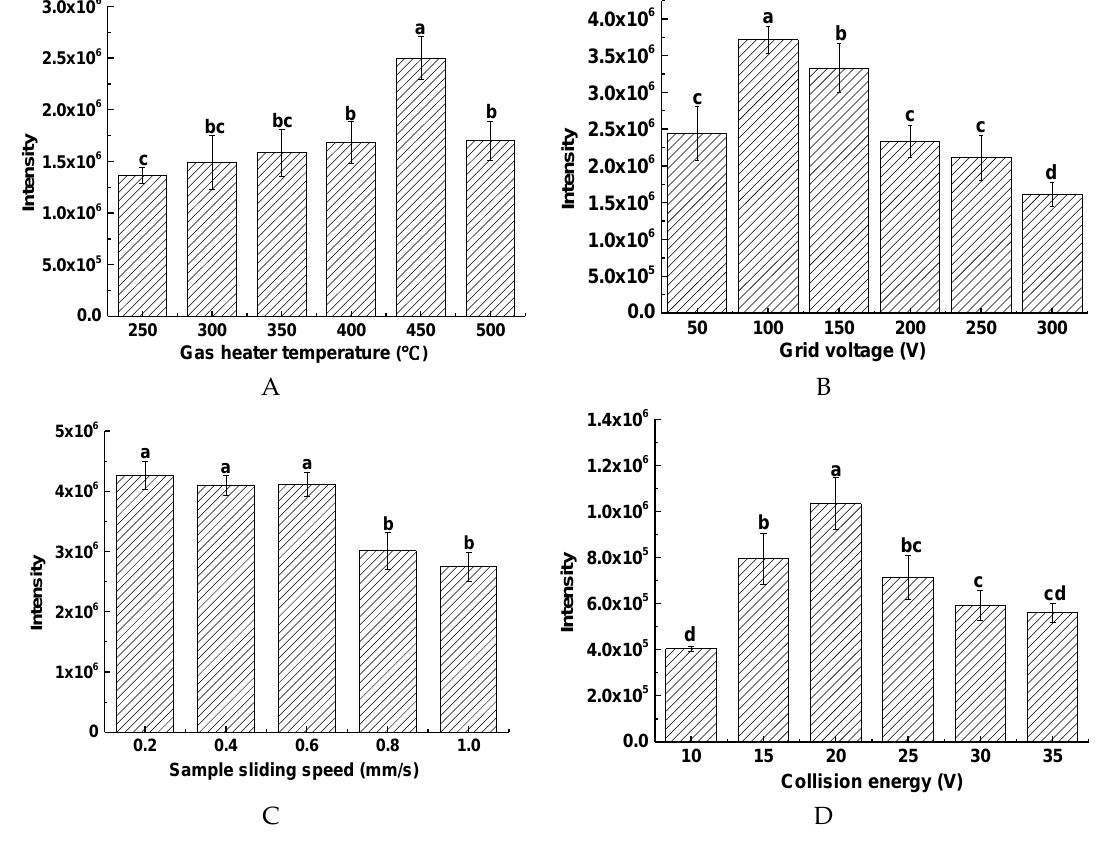
Figure 3. Optimization of determination conditions of SPD by DART-MS/MS: ( A ) gas temperature; ( B ) grid voltage; ( C ) sample sliding speed; ( D ) collision energy. Bars with different alphabets indicate significant differences between the mean values ( p < 0.05), while the same letters indicate no significant differences between the means values ( p > 0.05).